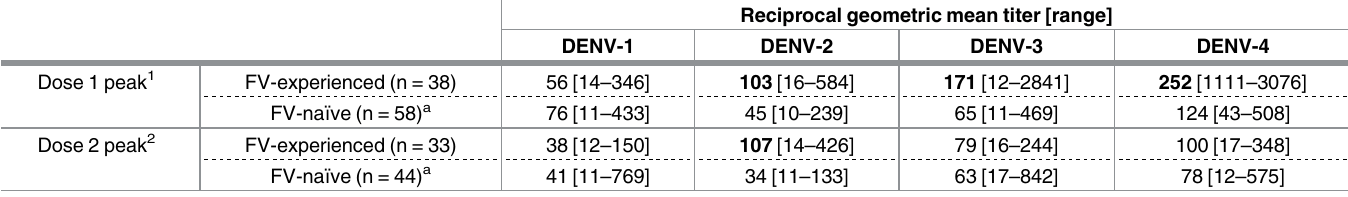
1 Mean peak neutralizing titer after Dose 1 of TV003 (measured between days 0–90 after vaccination) administered to subjects who were flavivirus-exposed versus flavivirus–na ï ve at Day 0: DENV-1 ( P = 0.09), DENV-2 ( P = 0.001), DENV-3 ( P = 0.0003) DENV-4 ( P = 0.004). 2 Mean peak neutralizing antibody titer after Dose 2 of TV003 (measured between days 0–90 after second dose, i.e. study days 180–270) administered to subjects who were flavivirus-exposed versus flavivirus–na ï ve at Day 0: DENV-1 ( P = 0.52), DENV-2 ( P < 0.0001), DENV-3 ( P = 0.2), DENV-4 ( P = 0.16). Significant values ( P < 0.03 level after adjusting for multiple comparisons) in BOLD . a TV003 vaccine response data in flavivirus-naive subjects are from ref. [19], and include both cohorts (CIR279 and CIR268) from that study. There were eleven subjects who were seropositive (PRNT 50 > 1:10) on day 0: DENV-1 (n = 4), DENV-2 (n = 1), DENV-3 (n = 3) and DENV-4 (n = 3), however reciprocal PRNT 50 values were 10–20, indicating low level of